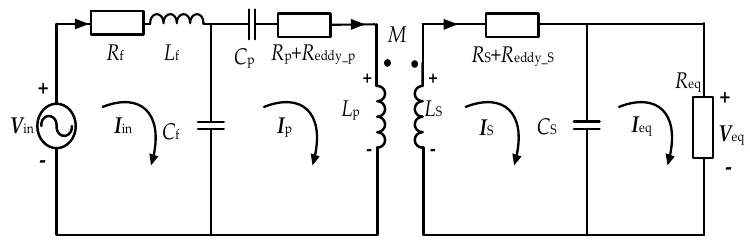
Figure 5. Equivalent circuit of the WPT system in seawater condition.